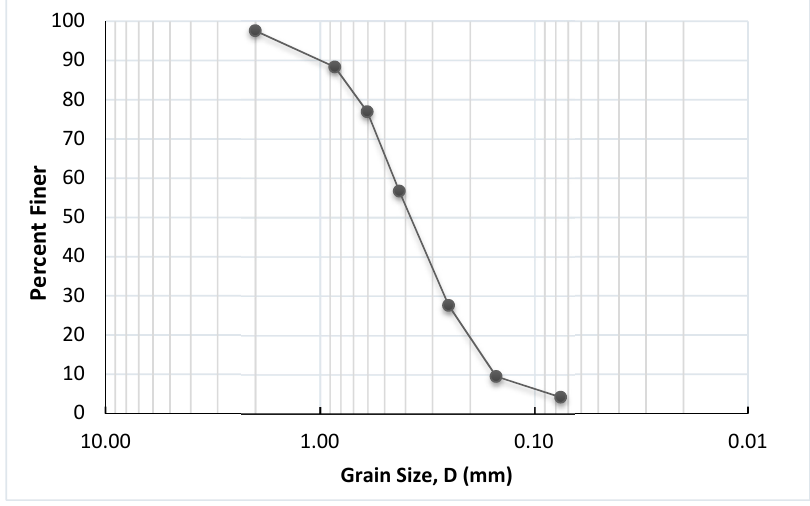
Figure 3. Grain-size distribution of the waste sand. Table 1. Summary of the physical properties of the waste sand.